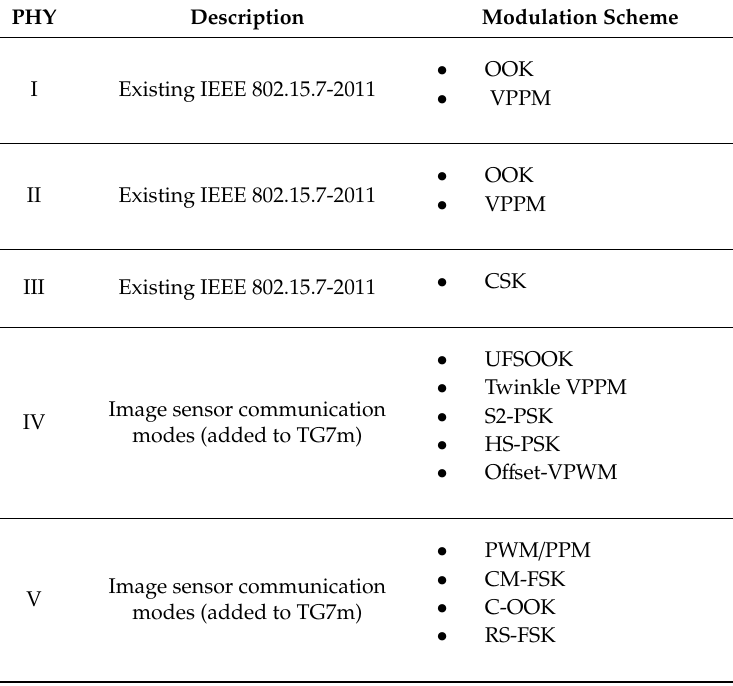
Table 1. IEEE 802.15.7m initial operating modes.